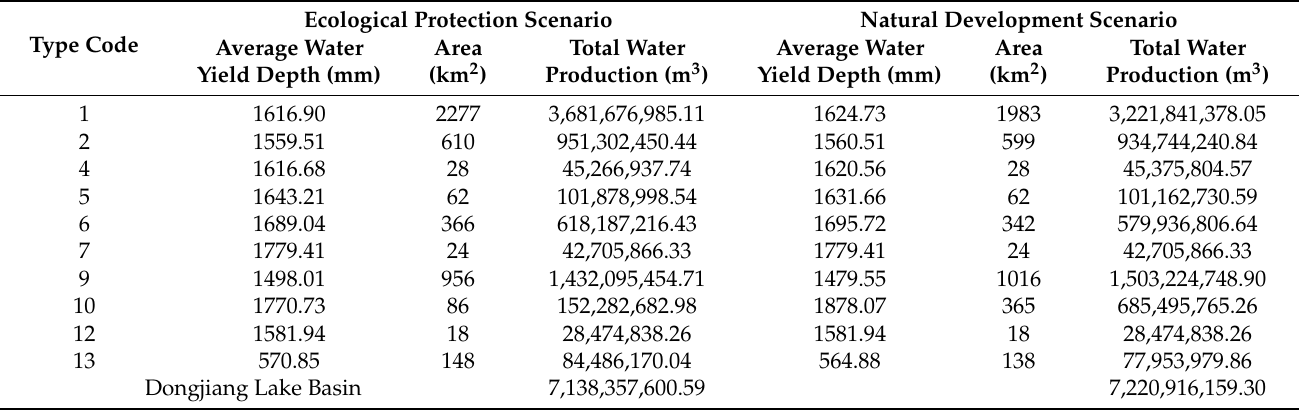
Figure 8. Distribution of water yield under different LULC data of the Dongjiang Lake Basin in 2030. ( a ) The LULC natural development scenario; ( b ) The LULC natural development scenario. Table 5. Total amount of water yield under different development scenarios in